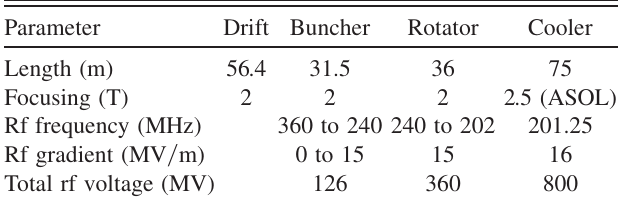
TABLE I. Component parameters describing the front-end